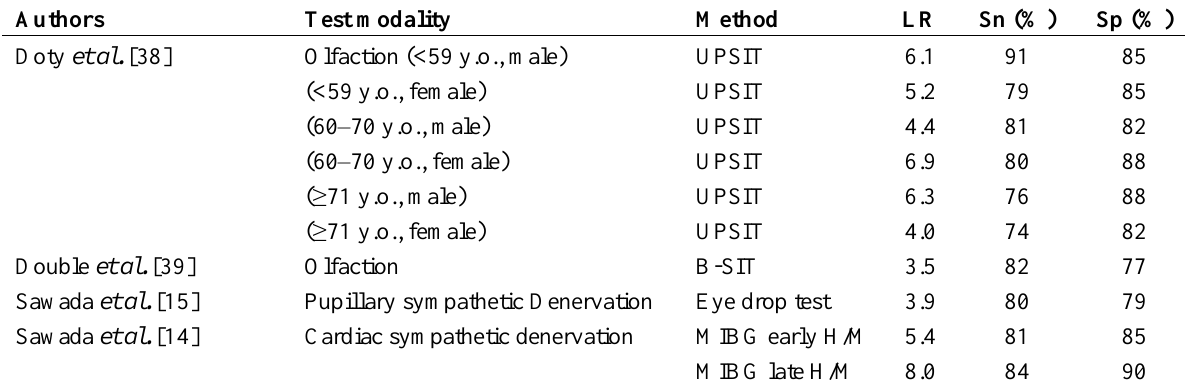
Table 3. Non-motor test for diagnosis of Parkinson disease. Figure 3. Pupillary mydriasis by cocaine and